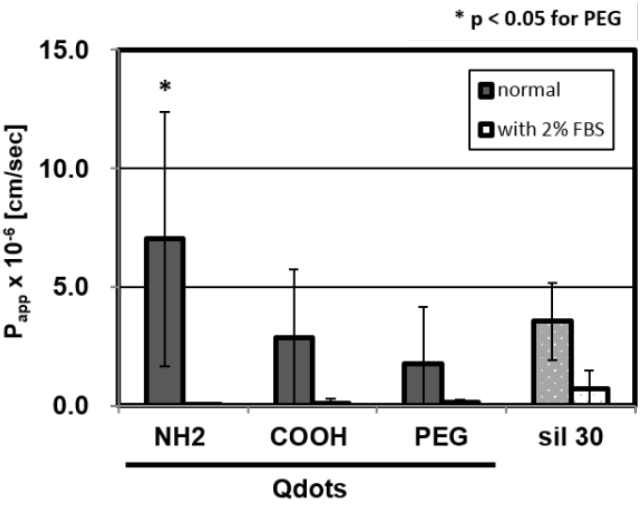
Figure 4. Permeability of three different electrically charged Qdots (-COOH, -PEG, -NH with or without serum. We tested these P These values are means ± SD of 6–8 wells from two or three independent experiments.